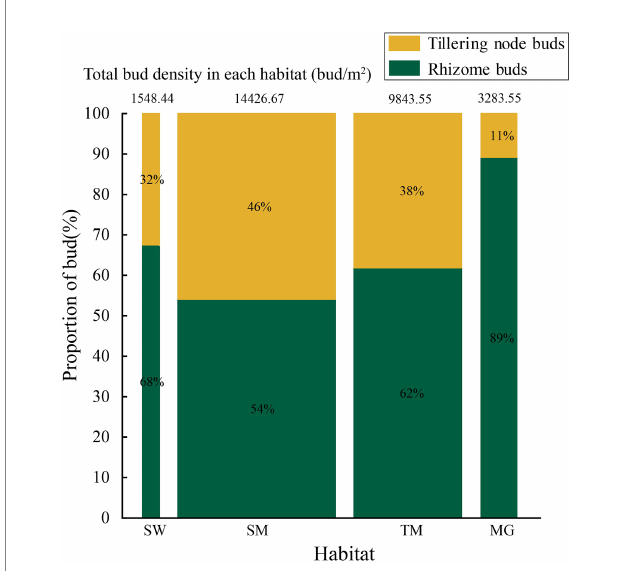
FIGURE 2 Allocation of buds by Deyeuxia angustifolia in four habitats.